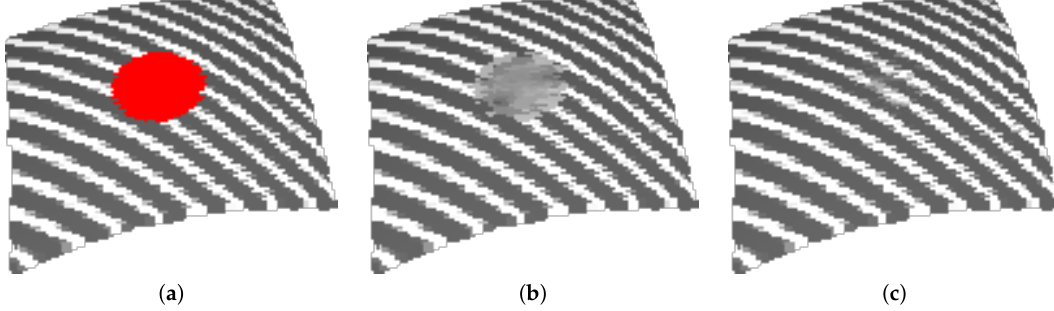
Figure 2. Inpainting of the color on a point cloud. ( a ) Point cloud to inpaint; ( b ) result of inpainting with w = 1; ( c ) result of inpainting with w based on the patch defined on point clouds (see Section 4.2).